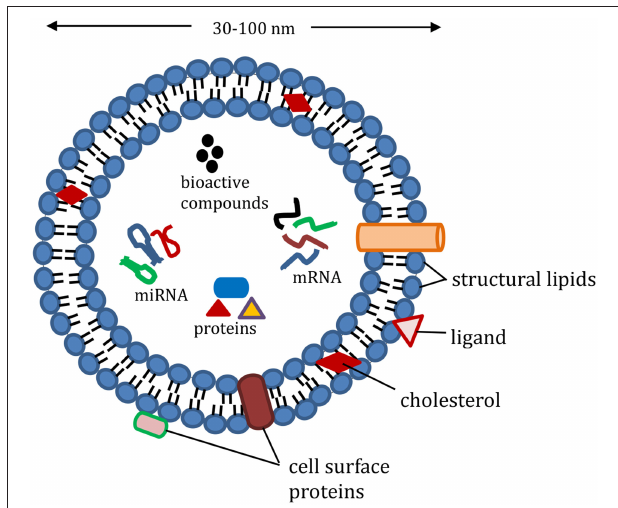
FIGURE 1 | Representative structure of exosomes loaded with cargo (proteins, e.g., heat shock proteins, Ras-related protein; mRNA, miRNA, and non-coding RNA; nutrients, and bioactive compounds); structural lipids in exosomes include ceramide, sphingolipids, and phospholipids; exosome membrane proteins include major histocompatibility complex-II, cluster of differentiation, and